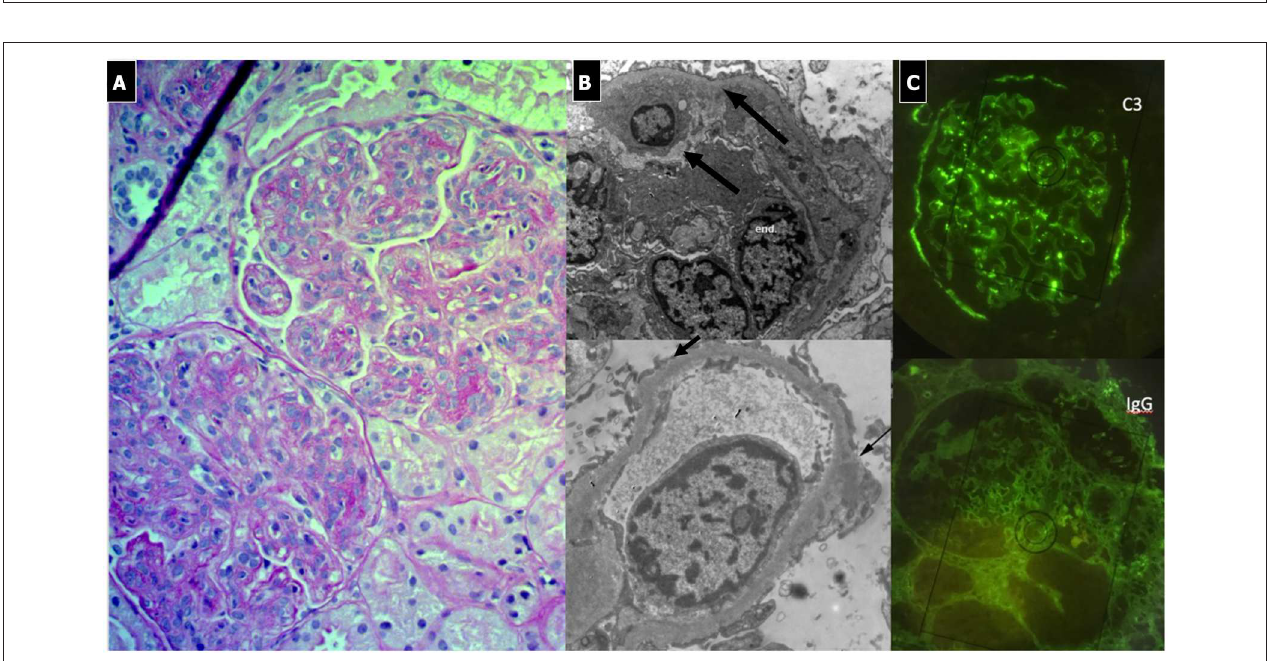
FIGURE 4 | Activation pathways of the complement system in normal subjects. It is possible to note the complement regulation factors, such as CFH and CFI, and their point of action along the cascade phases (e.g., the C3 conversion for the CFH and CFI factors).